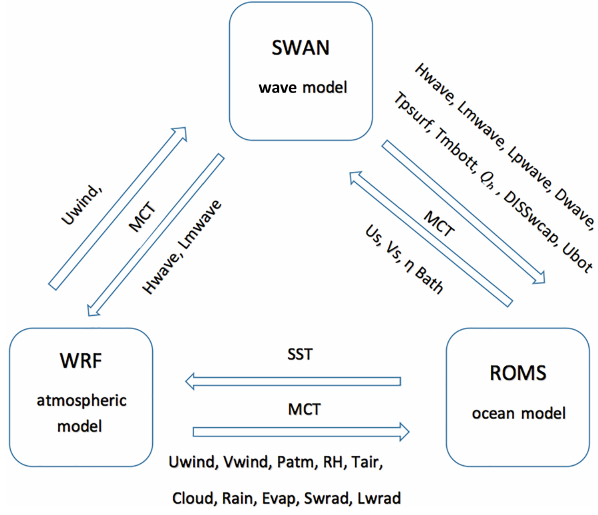
Figure 1. The block diagram shows the component models WRF, ROMS, and SWAN of the COAWST modeling system together with the variables exchanged among the models. MCT, the model cou- pling toolkit, is a model coupler used in the COAWST